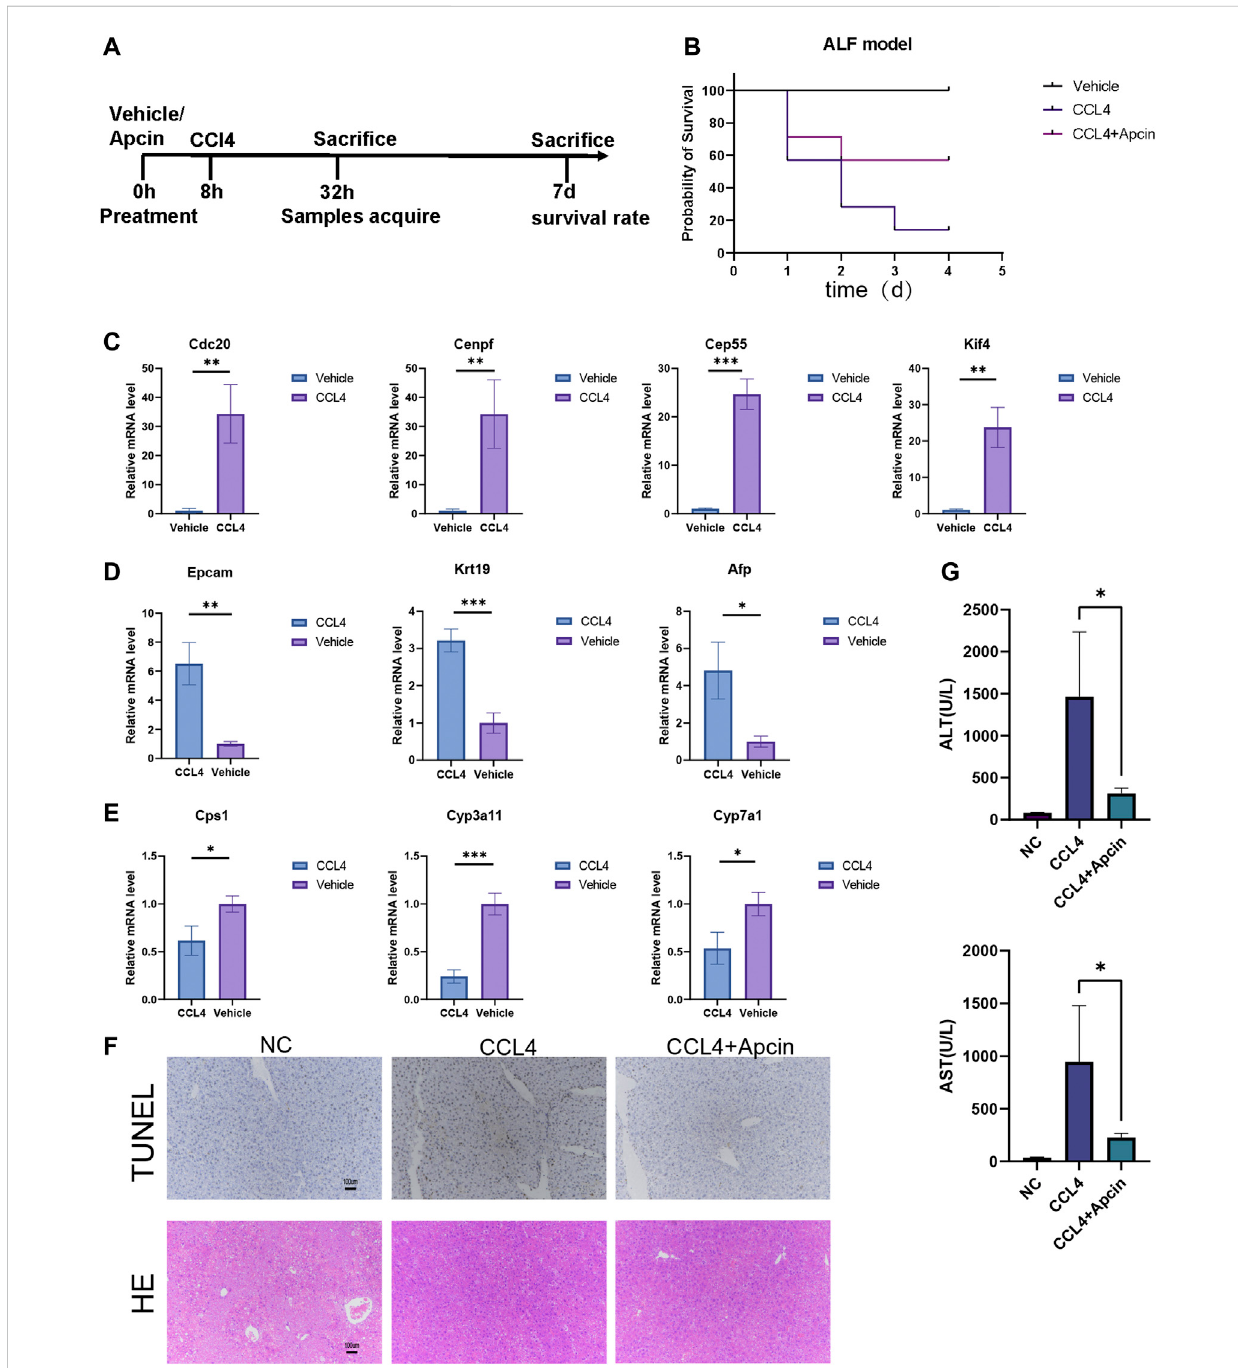
FIGURE 7 CDC20 inhibitor Apcin alleviates ALF. (A) The fl ow diagram demonstrates the ALF model construction and treatment. (B) The survival rate of ALF mice with or without Apcin pretreatment. N = 7. (C – E) The relative expression of hub genes (C) , progenitor genes (D) , and functional genes (E) between ALF and vehicle mice. N = 3. (F) Representative TUNEL (upper panels) and H&E (lower panels) staining of liver tissues harvested at 24 h post CCL4inductionwithorwithoutApcinpretreatment. N =3(Scalebars=100 µm). (G)